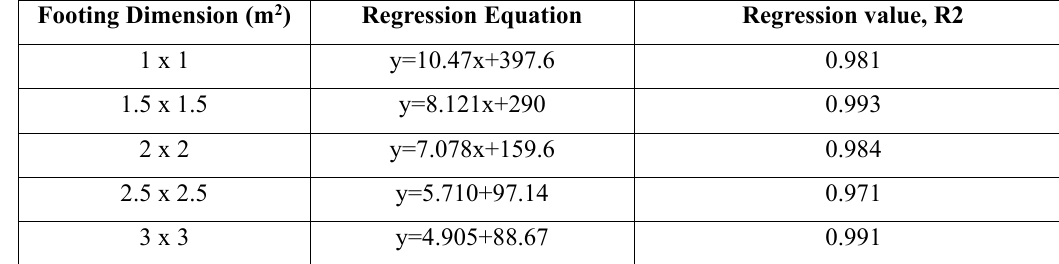
Regression analysis of Stress vs Settlement (spacing 2.5 m fixed between two adjacent footings). Footing Dimension (m 2 )